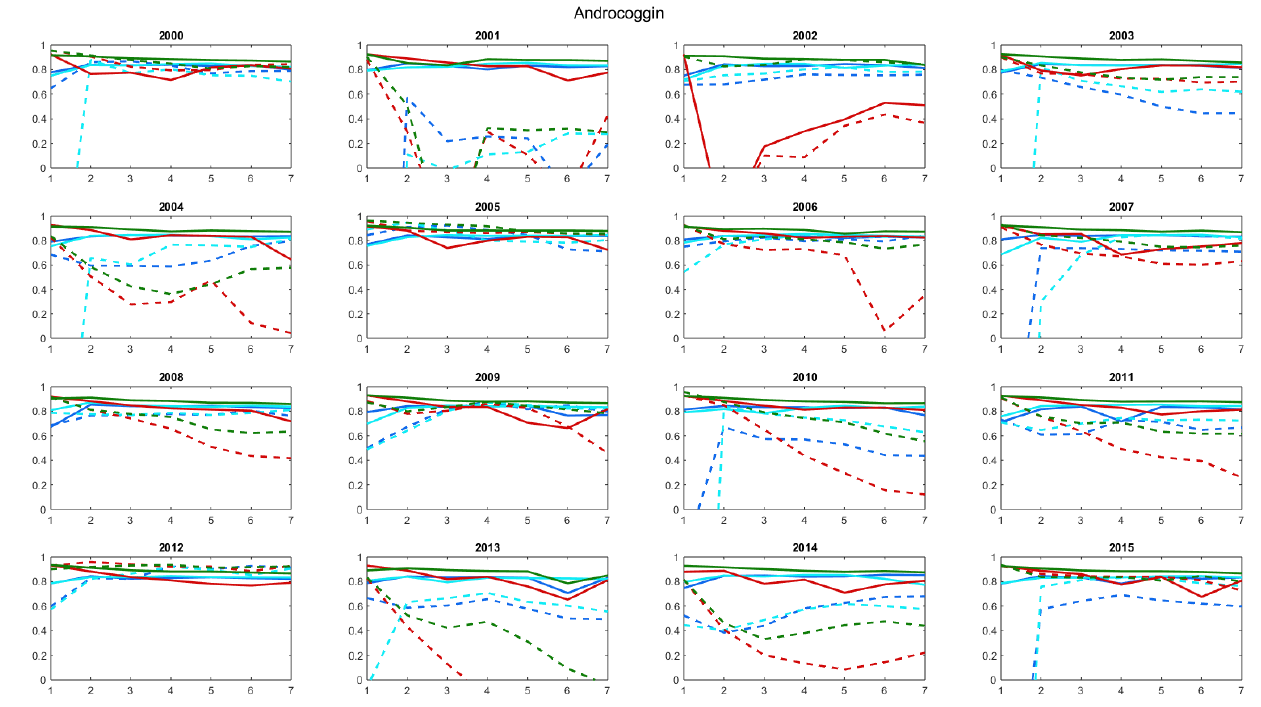
Figure 7. Evolution of NSE across the 7-day forecast window for the Androscoggin watershed. The training step is in full line, while leave-one-out validation is in dotted line. QP results are represented in red, SMP in blue, dSMP in cyan, and QSMP in green. Each subplot corresponds to a specific step of our cross-validation approach with the year used in validation in sub-title.